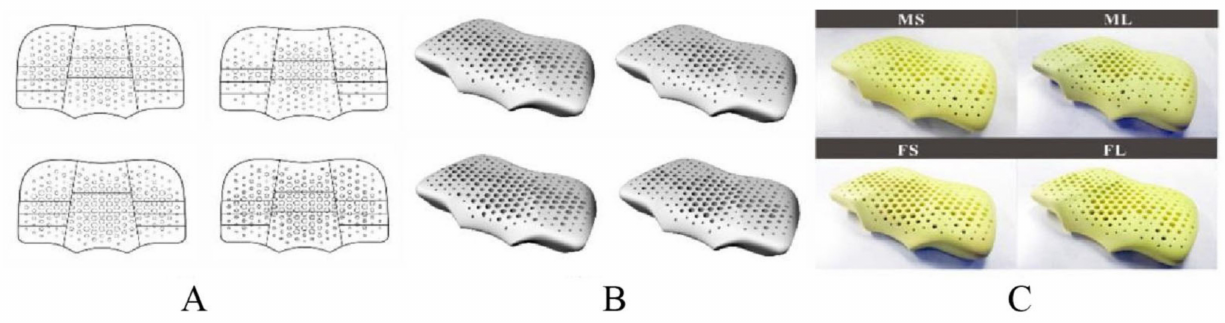
Figure 7. Pillow partition: three partitions for the supine position (A1, A2, A3) and four partitions for the lateral position (B1, B2, B3, B4) [2] (open access).